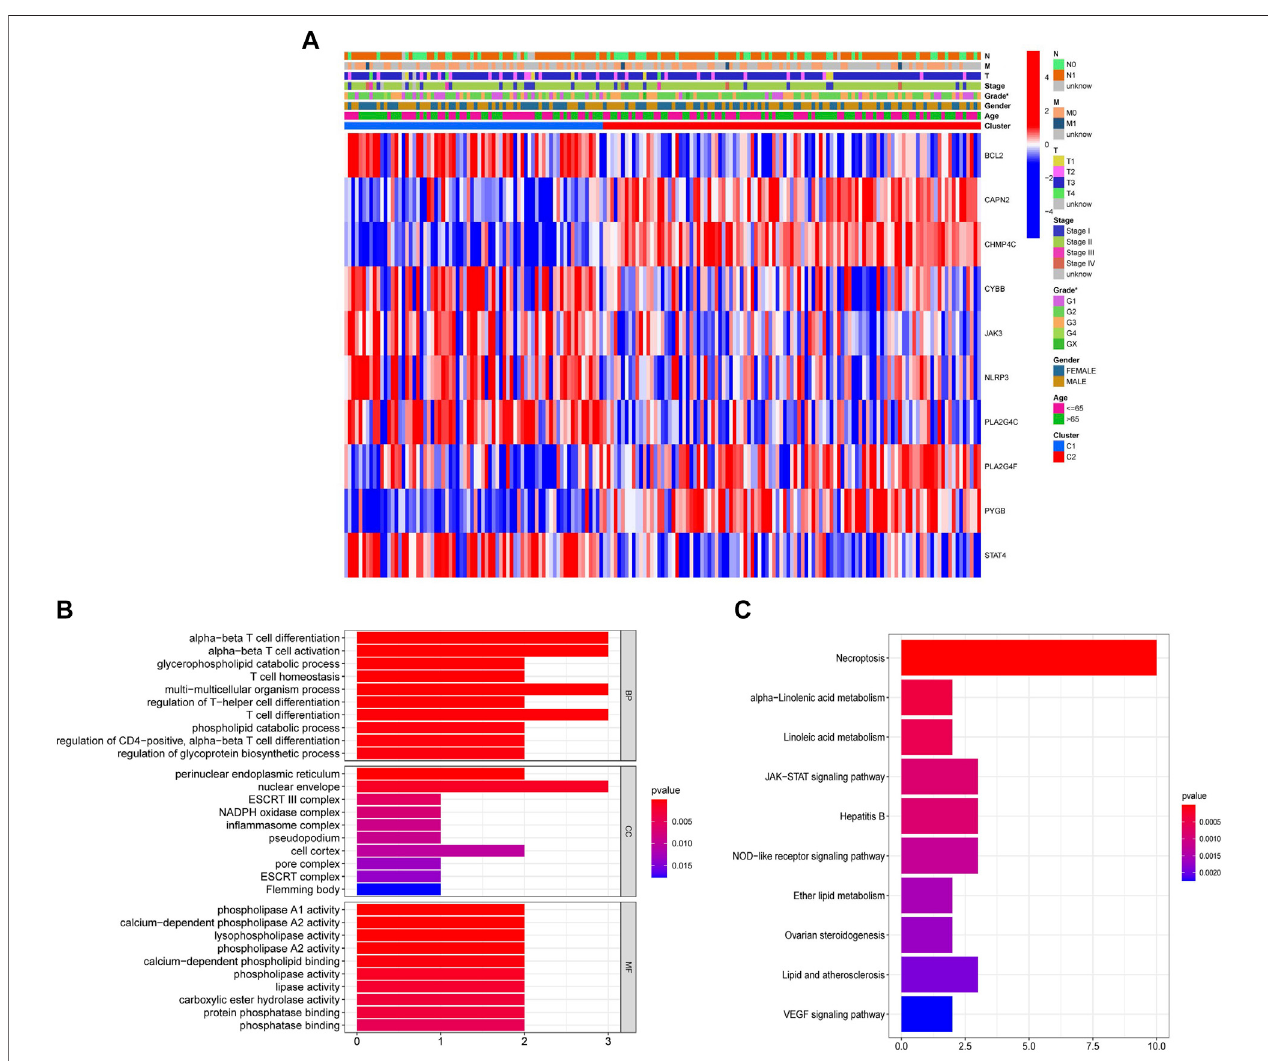
FIGURE4| Identi fi cationofthedifferentialexpressionof22NRGsbetweencluster1andcluster2. (A) Heatmapwiththecorrelationbetween10differentiallyexpressed NRGs in two clusters and clinical characteristics (* p < 0.05). (B) GO analysis of 10 differentially expressed NRGs. (C) KEGG analysis of 10 differentially expressed NRGs.